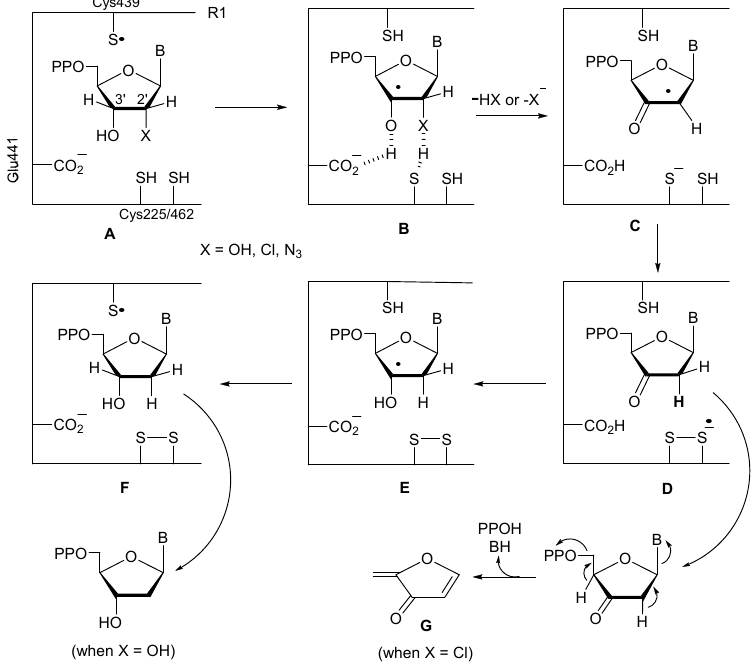
Figure 1. Mechanisms proposed for reduction of ribonucleoside diphosphates and inactivation of RDPRs by 2’-chloro analogues [1].